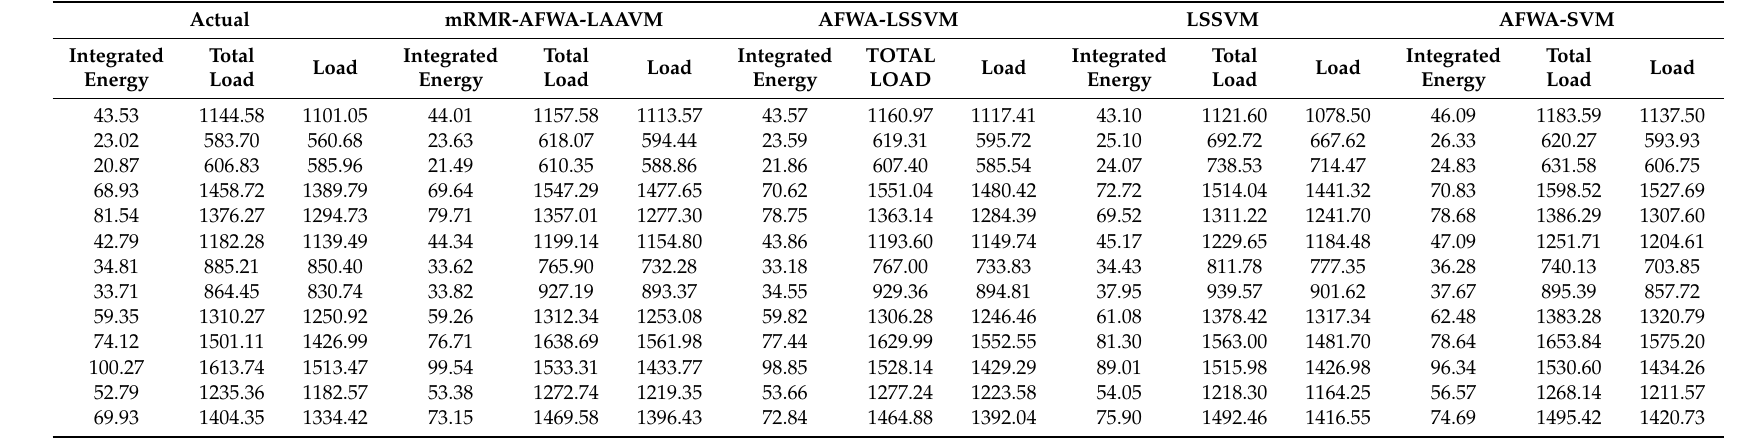
Table 8. Forecasting results of four